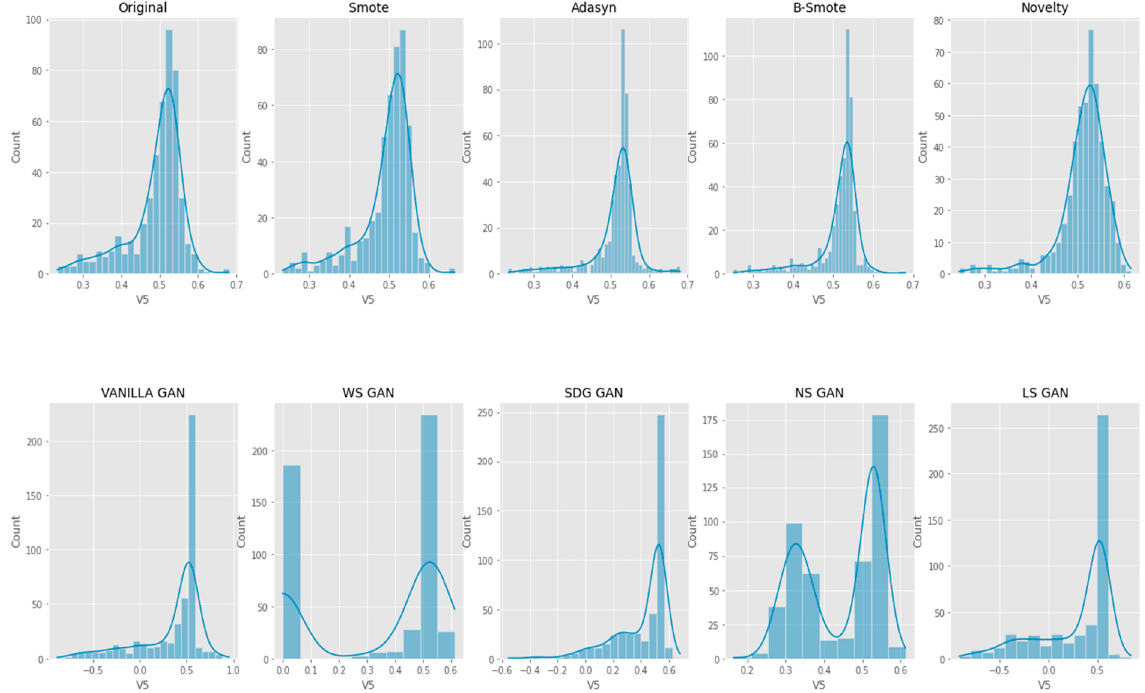
Figure 15. Univariate V5 Feature Distribution comparison of Original Data, SMOTE, ADAYSN, B-